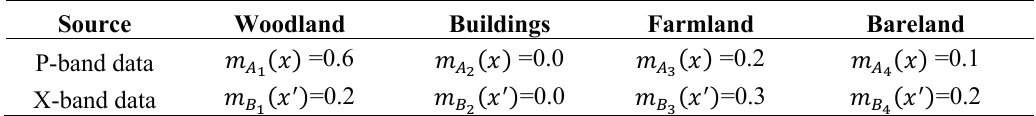
Table 2. Mass function values of the four